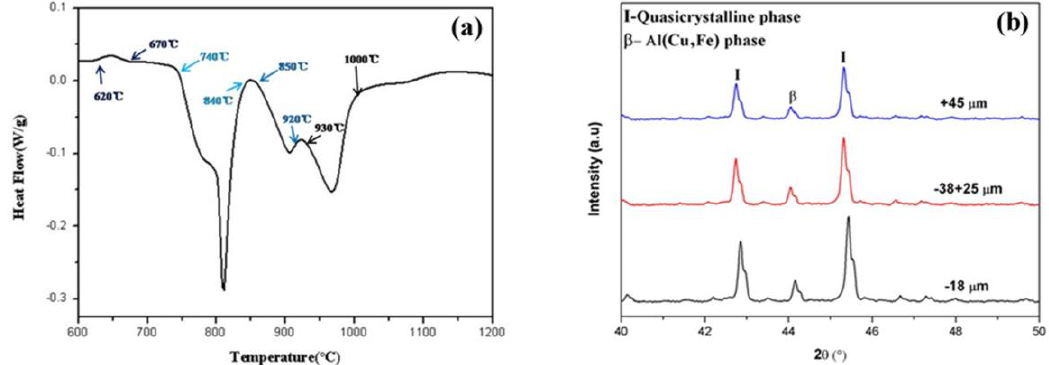
Figure 2. ( a ) DSC results of Al 50 Cu 20 Fe 15 Si 15 powder measuring 25 µm to 38 µm; ( b ) XRD curves for the annealing of Al 50 Cu 20 Fe 15 Si 15 powder sieved with different mesh size at 750 ℃ /12 h.